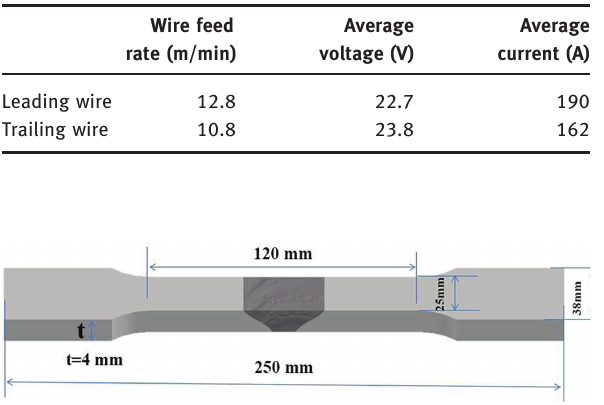
Figure 3: Dimensions of the sample for performance testing.